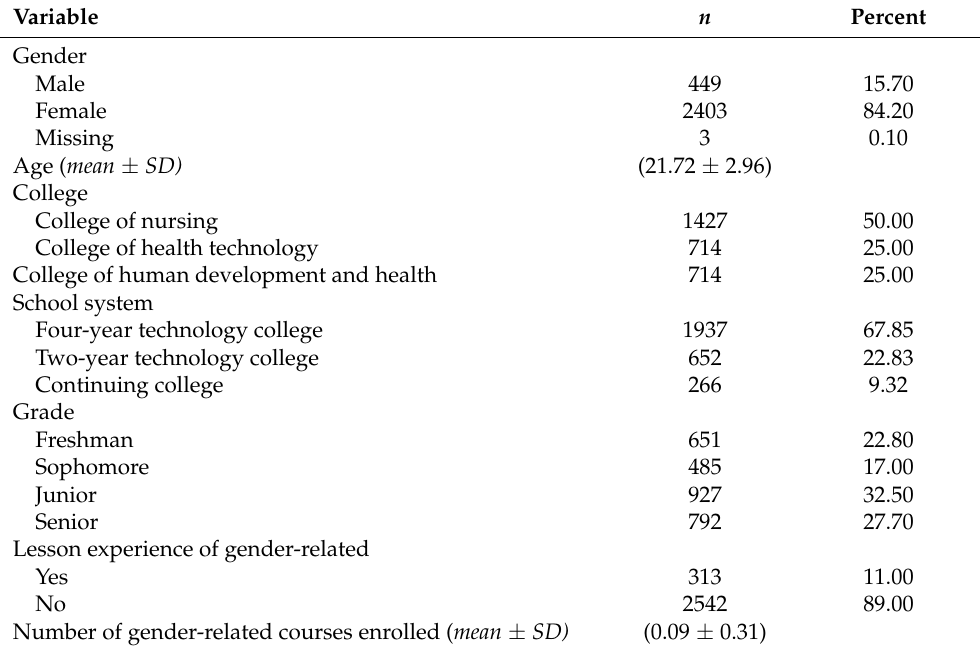
Table 1. Sample Profile ( n = 2855).